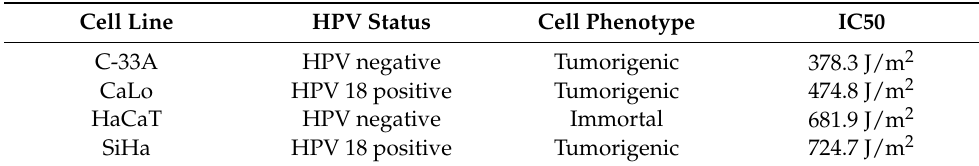
Table 1. IC50 of cells UVB-IR and cell